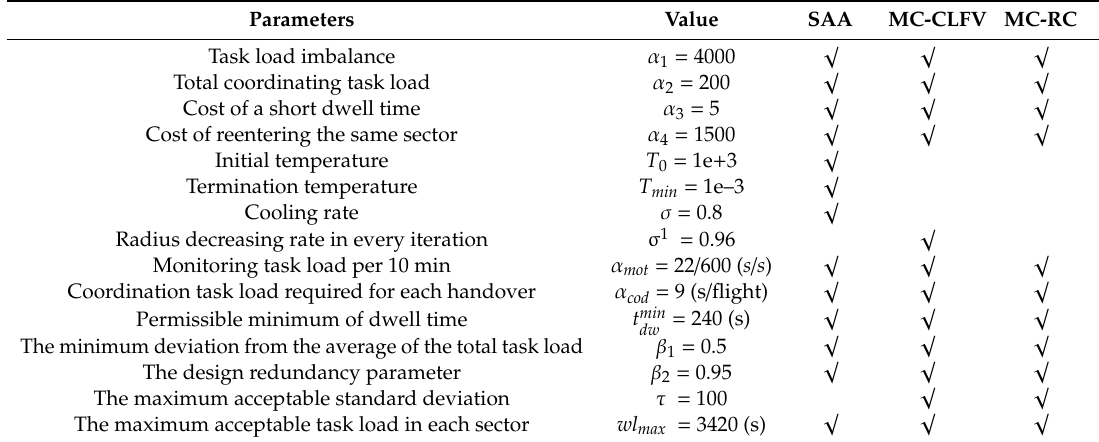
Table 4. Parameters used in the algorithm.